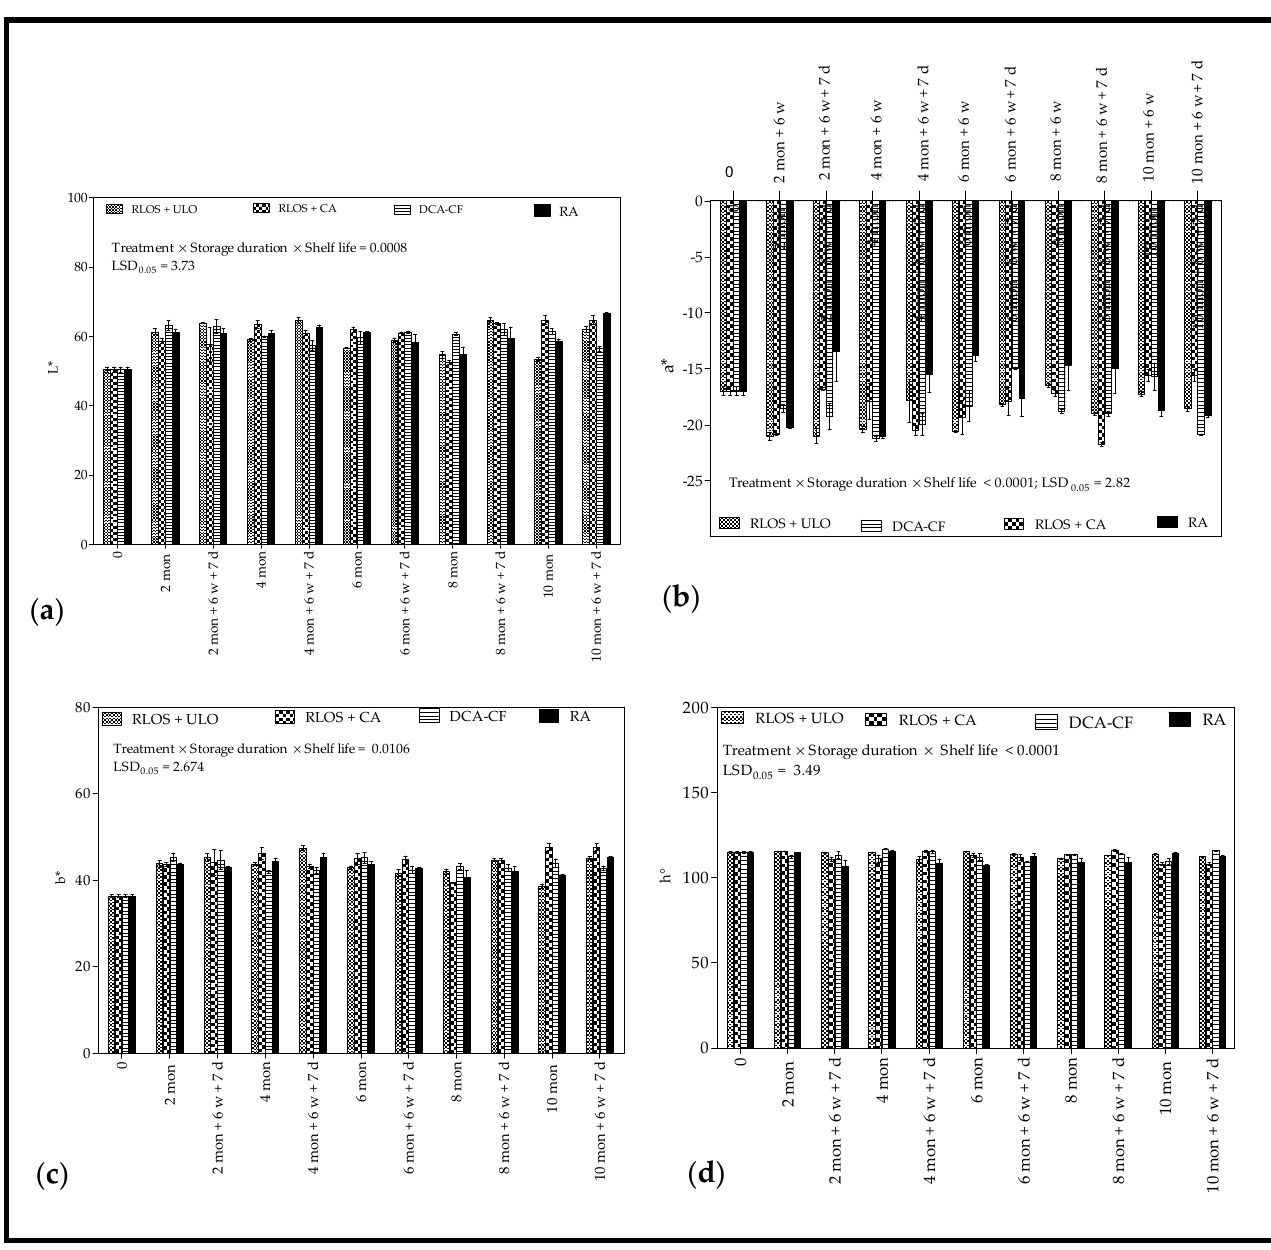
Figure 3. Background color ( a ) lightness (L*), ( b ) redness/greenness (a*), ( c ) yellowness/blueness (b*) and ( d ) hue angle (h°) of ‘Granny Smith’ apples harvested in the 2016 season at commercial maturity and stored for up to 10 months at 0 °C in various storage conditions, evaluated every two months followed by a 6 week simulated shipment and handling period, and at 7 days on the shelf (20 °C and 65% RH). Vertical bars represent the standard error (SE) of mean values of 3 replicates (1 replicate = 10 fruit). LSD 0.05 represents least significant difference ( p < 0.05). For storage duration, mon—months; w—weeks; and d—days. RLOS—repeated low oxygen stress; ULO—ultra-low oxygen; CA—controlled atmosphere; DCA-CF—dynamic controlled atmosphere-chlorophyll fluorescence; RA—regular atmosphere.